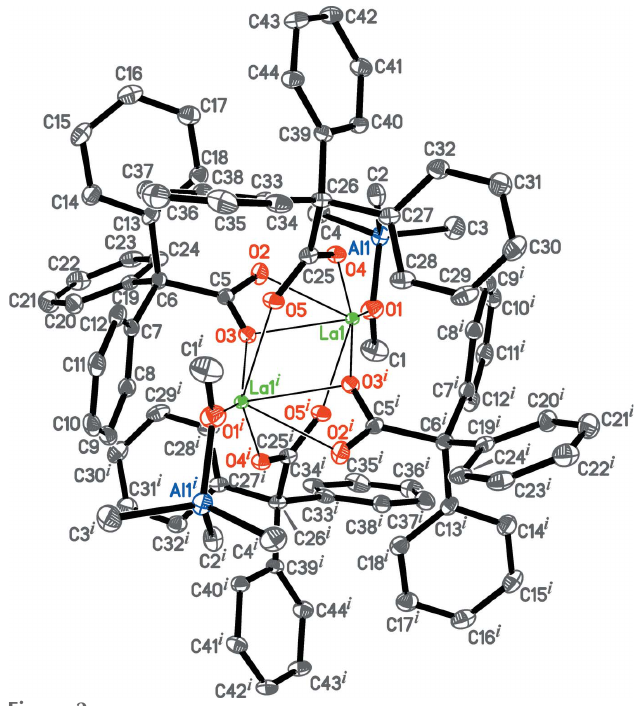
Figure 2 The molecular structure of the {La(Ph 3 CCOO) 2 (Me 3 AlOMe)} 2 unit in the title compound with displacement ellipsoids drawn at the 30% probability level. Hydrogen atoms and toluene solvent molecules are omitted for clarity. The La—O bonds are shown with thinner solid lines. The La—C interactions are not shown. Symmetry code: (i) (cid:3) x , (cid:3) y + 1, (cid:3) z + 1.